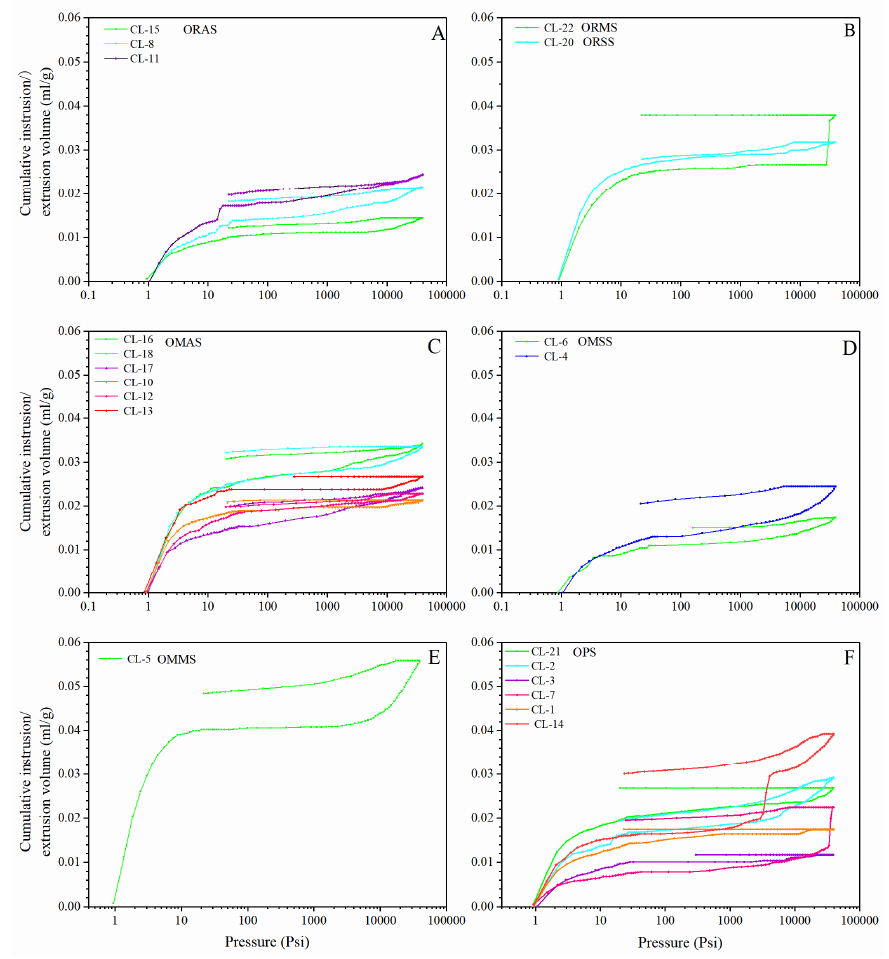
Figure 8. Mercury intrusion capillary pressure (MICP) intrusion and extrusion volumes for the Shahezi shales with different lithofacies in CFD.